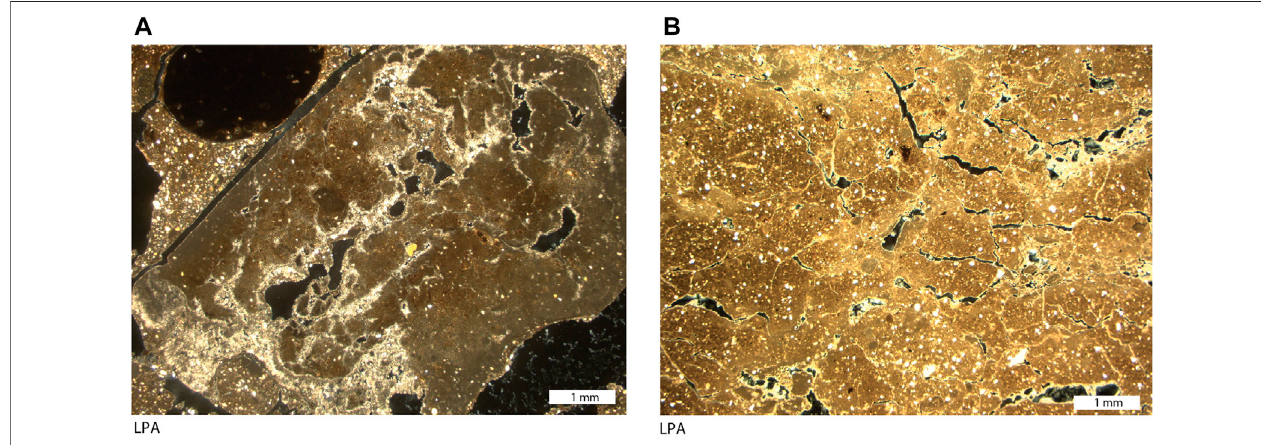
FIGURE 10 | Metallic oxyhydroxide characteristics, including (A) coatings (sample KH 14, layer XI) or (B) hypocoatings of void (sample KH 7H, layer IV) and (C) impregnationsintheformofedgings(sampleKH10H,layerVIII).Thetypes (A,B) re fl ecthydromorphicconditionswhichinvolvedoxidation – reductioncycles.Thedouble coatings (ferri-argilanes) observed in rootlet voids (B) are explained by the dissolution and leaching of carbonates from the fi ne fraction followed by iron precipitation.